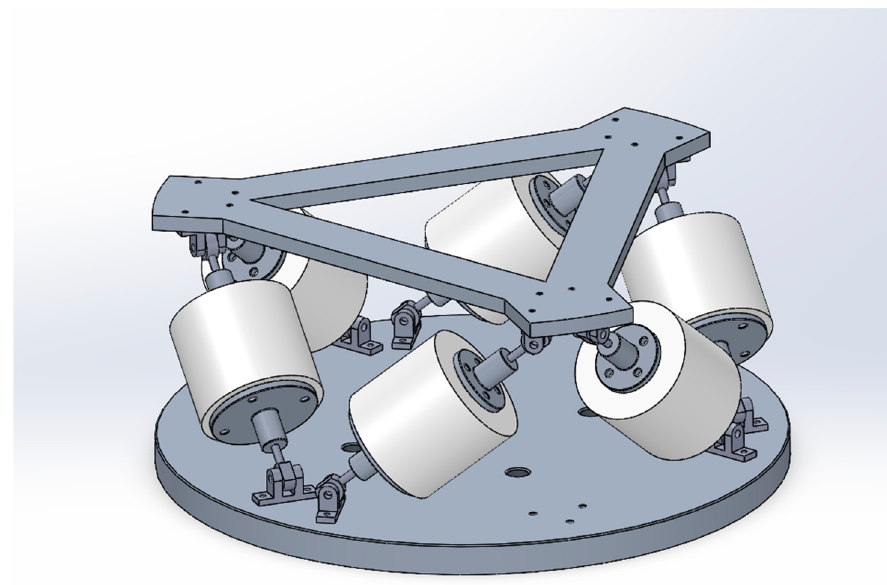
Figure 3. The design of the maglev Stewart platform. Table 1. Main specifications of the maglev Stewart platform.